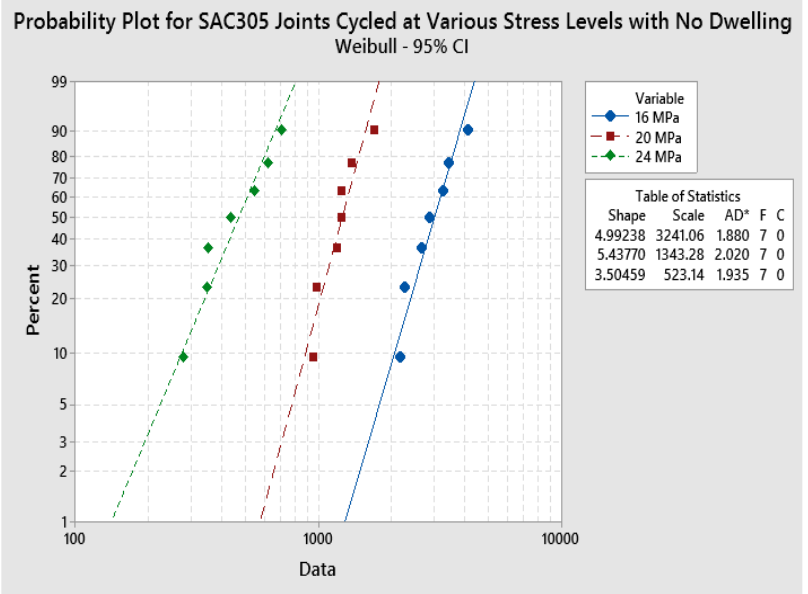
Figure 7. Weibull distributions for SAC305 joints cycled at different stress amplitudes at no dwelling. Prediction